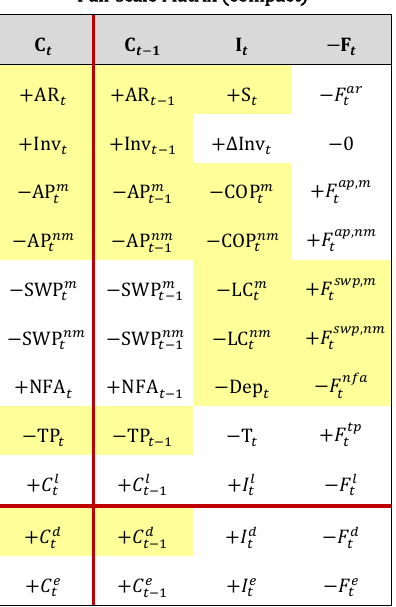
Figure 3. Full-scale matrix (compact form. See also Part I, Equation (33), right matrix). The yellow cells contain values that may be obtained from the assumptions via some simple calculations.